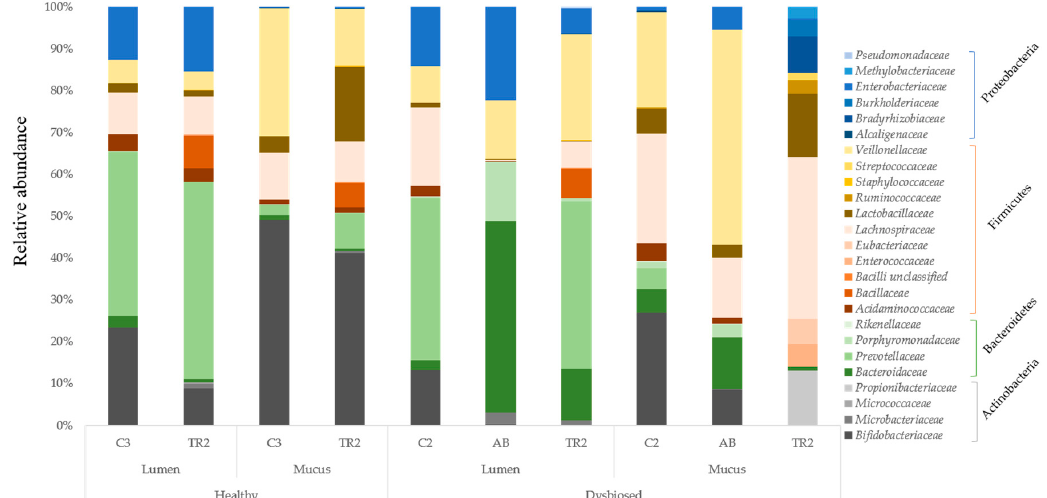
Figure 4. Relative abundance of different families belonging to specific phyla in the lumen and mucus of the proximal colon of the M-SHIME ® treated with MegaDuo ™ under healthy and antibiotic-induced dysbiosed conditions. C3 = end of the control period (healthy condition); TR2 = end of the treatment period; C2 = end of the control period (dysbiosed condition); AB = end of the antibiotic period; M-SHIME ® = mucosal simulator of the human intestinal microbial ecosystem.